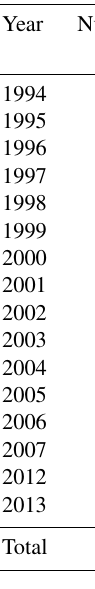
Table 2. Number of profiles used to calculate the PCL temperature climatology per year between 1994 and